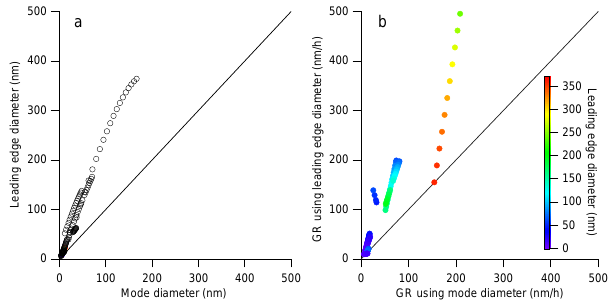
Fig. 3. Leading edge diameter versus mode diameter obtained from the SMPS data (a) . Comparison of the SMPS growth rates calcu- lated using the corresponding leading edge and mode diameters of (a) , color coded for leading edge diameter (b) . 1 : 1 lines are plotted as solid